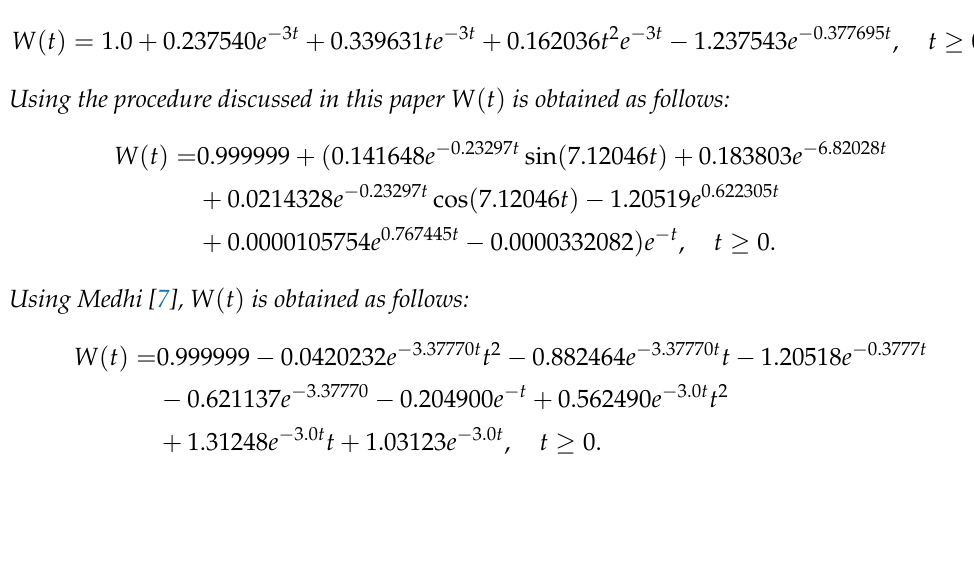
Figure 6. Comparison of CDF of queueing time obtained from this paper against that of Medhi [7]. Example 7. In reference [49], the sojourn-time distribution for the M / M [ a ] /1 queueing model under steady-state was numerically illustrated with the parameters a = b = 4, λ = 3.0 , and µ = 1.0, and ρ = 0.75 . Reference [49] p. 1511, obtained the expression for W ( t ) as